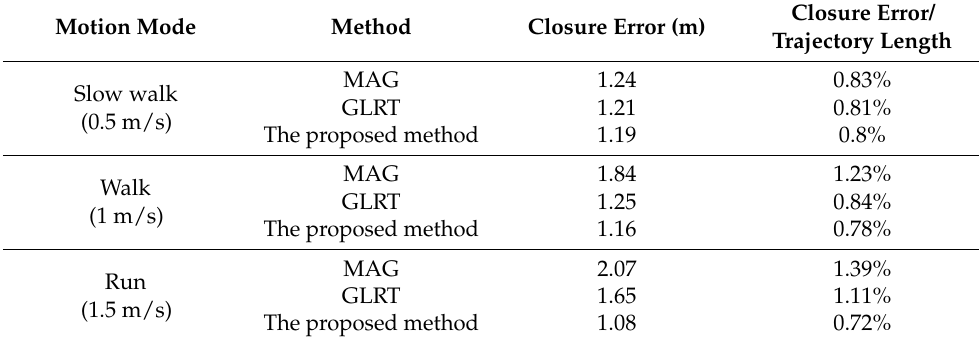
Table 3. Closure position error of zero velocity detection experiment.